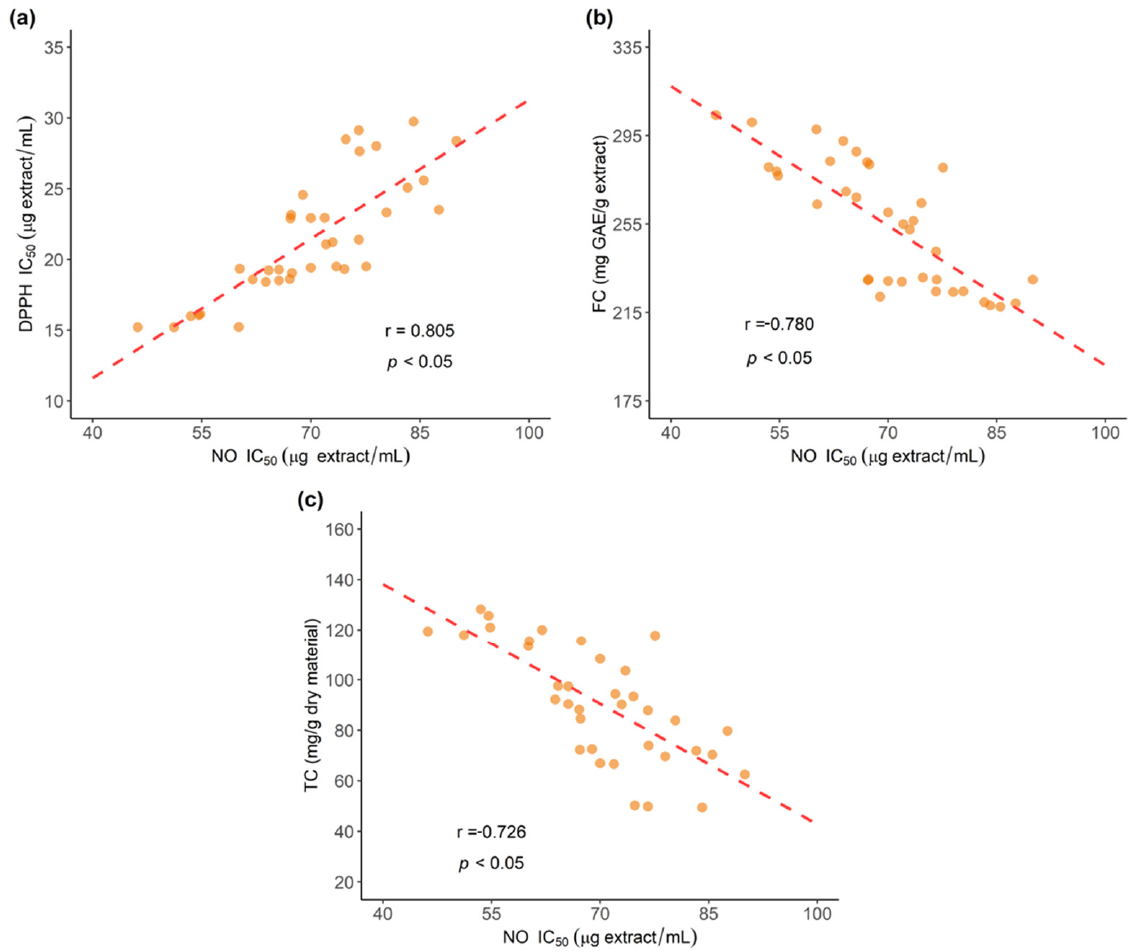
Figure 18. Correlation of antioxidant activity assessed through the Nitric Oxide (NO) radical scav- enging and: ( a ) DPPH antioxidant activity ( b ) Folin–Ciocalteu (FC) reducing capacity results; ( c ) total curcuminoids (TC) content determined by UPLC-DAD.